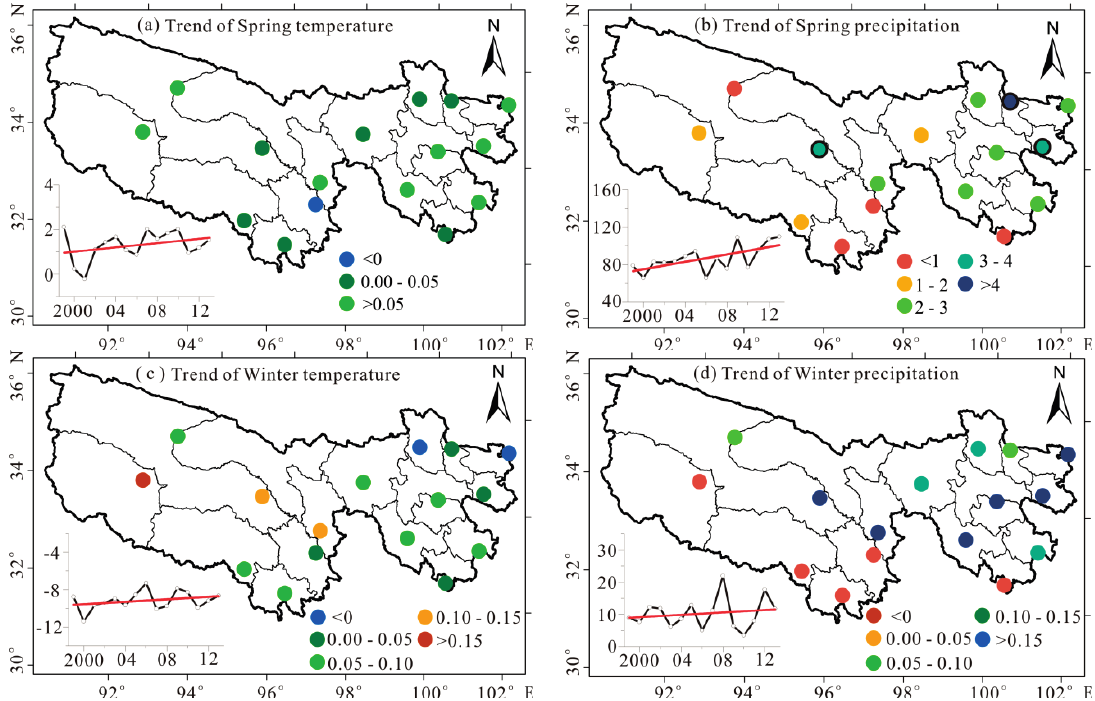
Figure 6. Trend of climatic factors: ( a ) spring temperature; ( b ) spring precipitation; ( c ) winter temperature; and ( d ) winter precipitation. The inset plot indicates the spatially averaged variation of climate factors ((a) slope = 0.048 °C/y, p = 0.24; (b) slope = 1.97 mm/y, p = 0.01; (c) slope = 0.07 °C/y, p = 0.28; (d) slope = 0.18